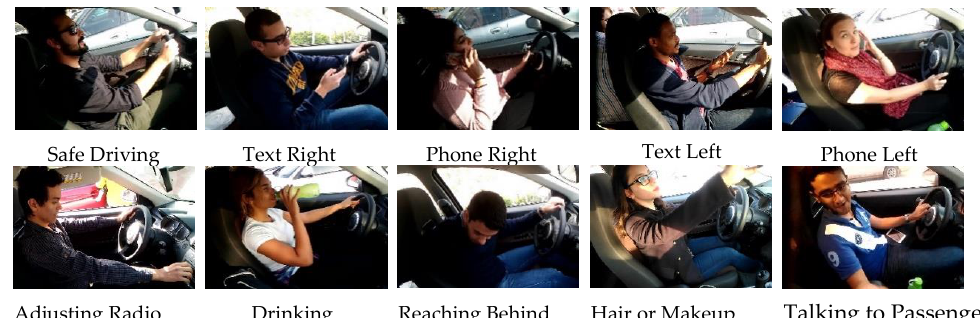
Figure 5. AUC Distracted Driver dataset [24].